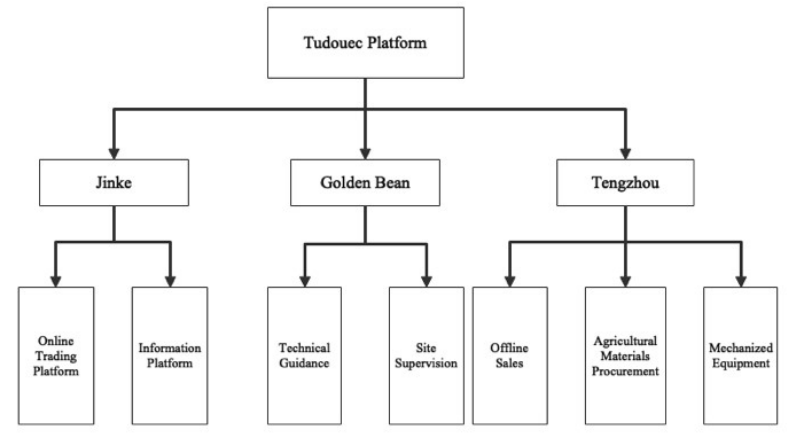
Figure 1. Organizational chart and departmental mission chart of Tudouec.